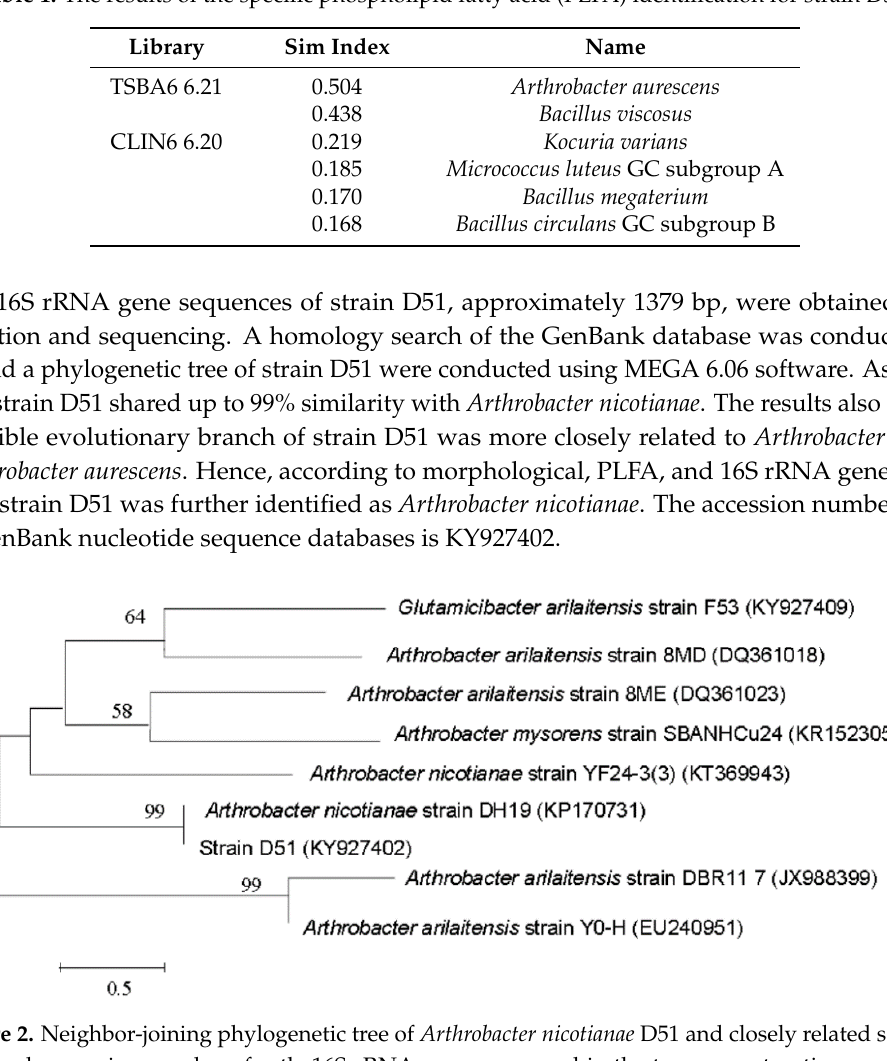
Table 1. The results of the specific phospholipid fatty acid (PLFA) identification for strain D51.